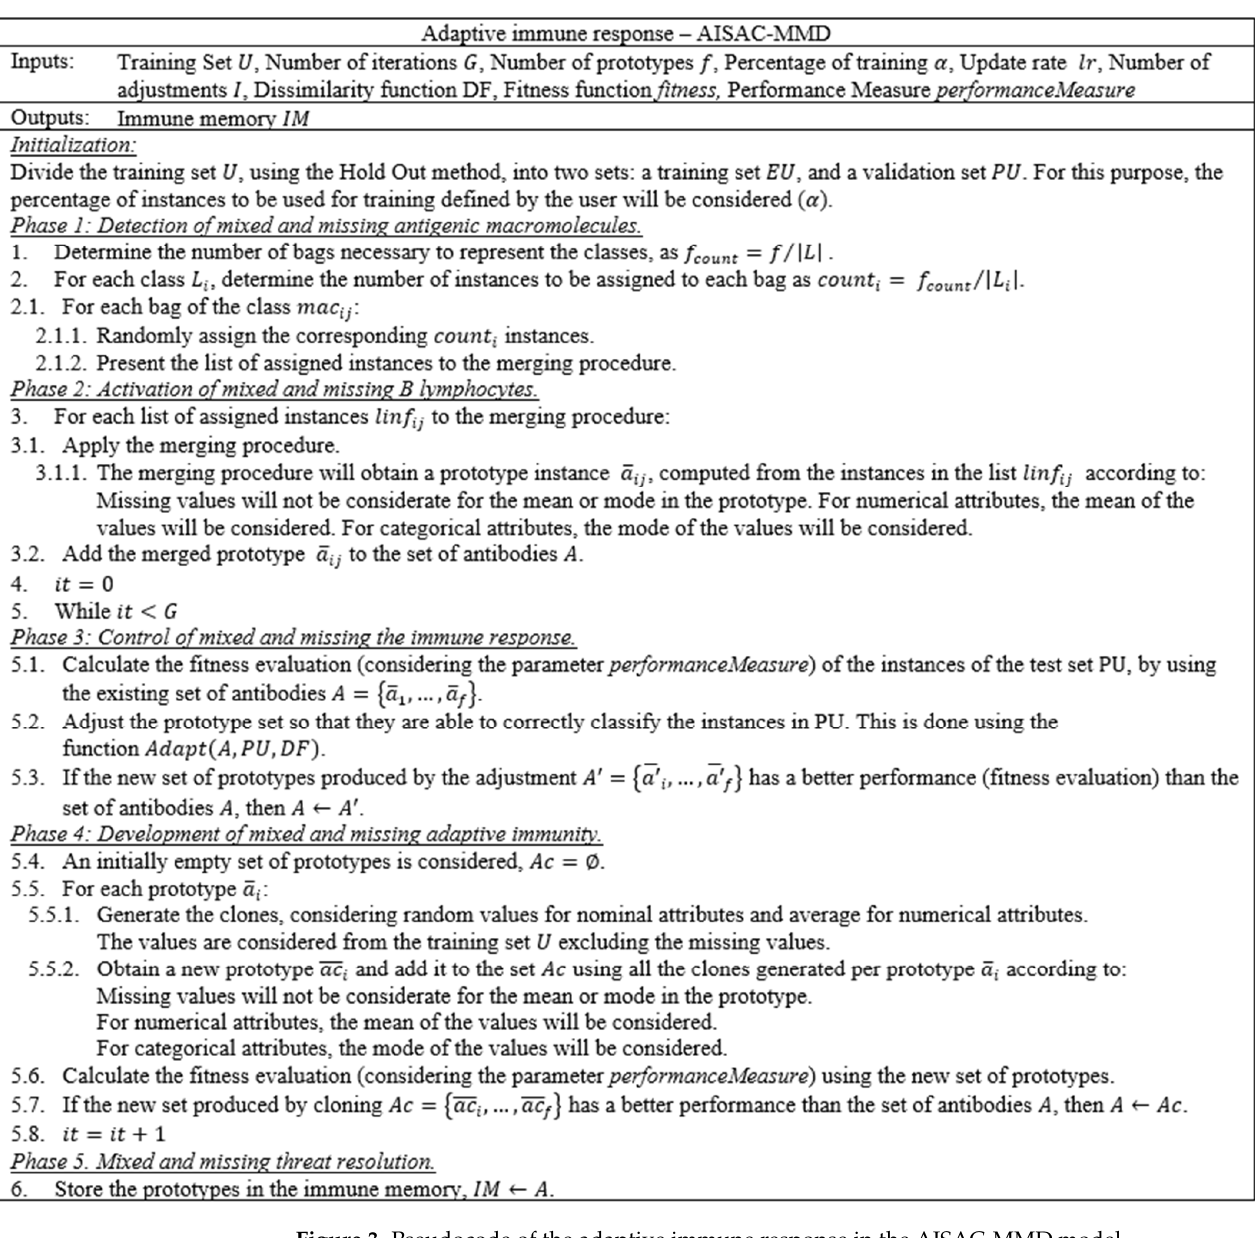
Figure 3. Pseudocode of the adaptive immune response in the AISAC-MMD model.